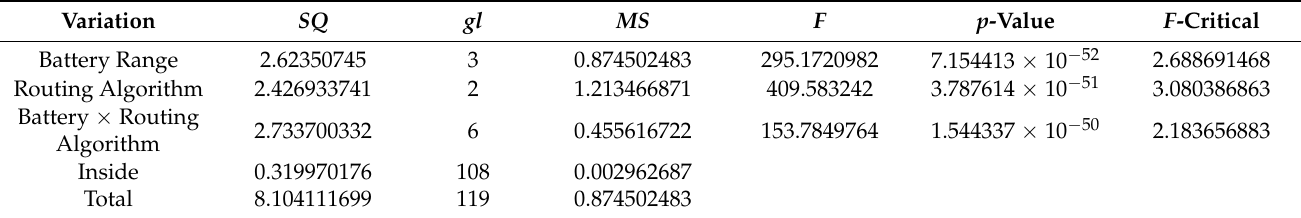
Table 8. Analysis of variance vs. delivery rate in scenario